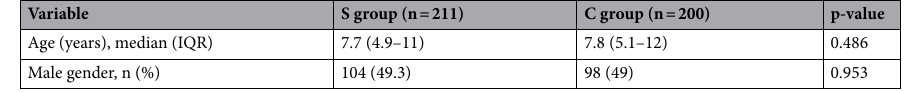
Table 1. Clinical characteristics of subjects. S study group, C control group, IQR interquartile range.